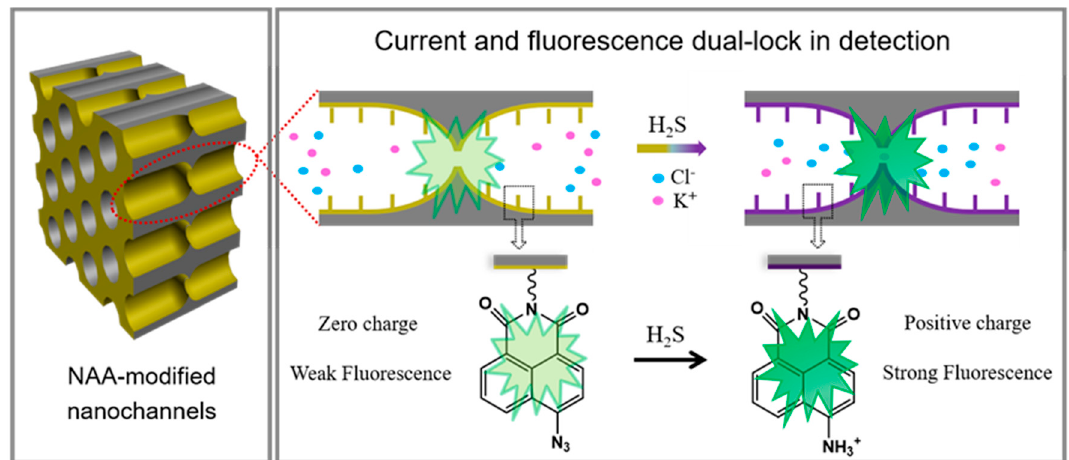
Scheme 1. Schematic of current and fluorescence dual-lock in the detection of H 2 S based on naphthalic anhydride azide (NAA)-modified hourglass-shaped alumina nanochannels. Upon the explosion of H 2 S, the azido groups would be reduced into the amino groups, which could trigger surface charges’ transformation from neutral to positive charges and fluorescence enhancement from weak to strong.